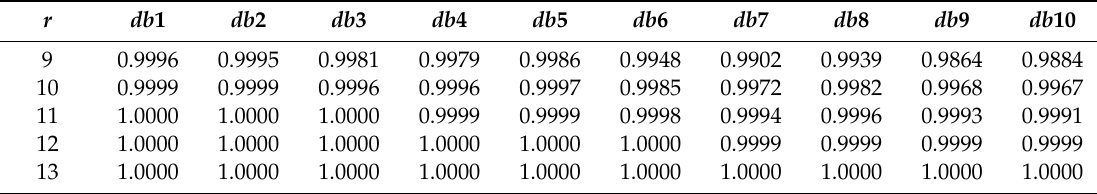
Table 16. Experimental results ( SSIM ) of 3D tomographic 12-bit image “Trufi_COR” DWT by using bit-width r of Daubechies wavelets filters coe ffi cients.